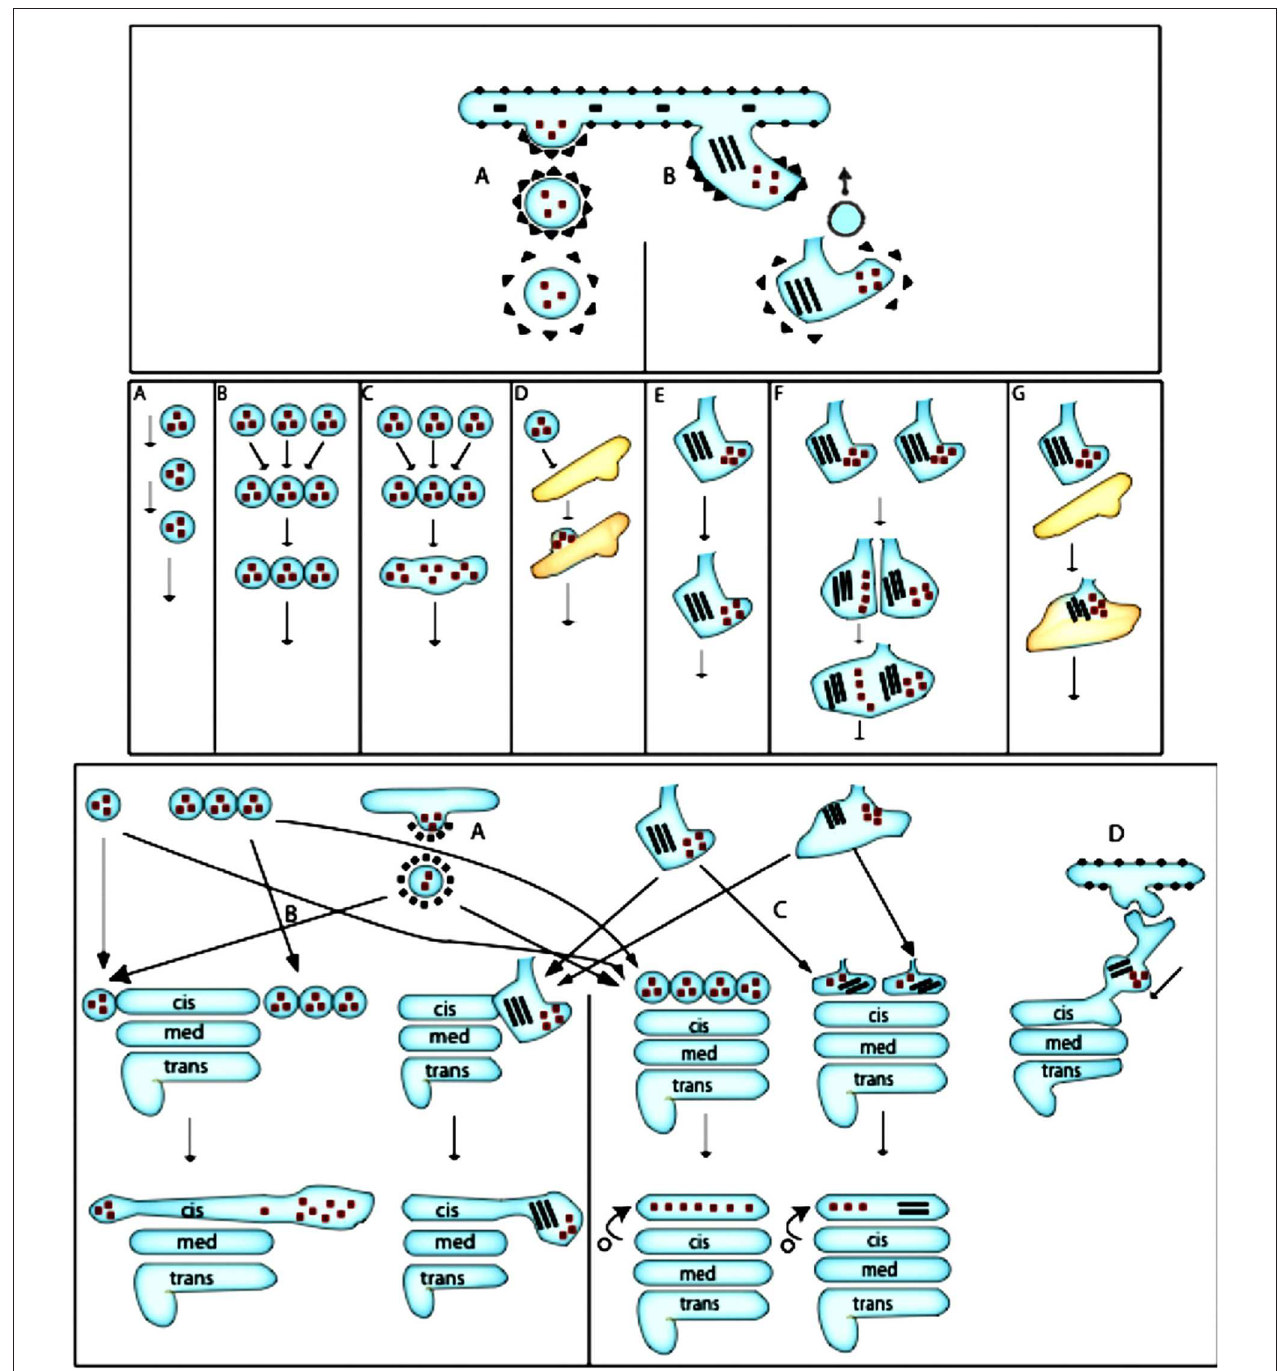
FIGURE 3 | Scheme of ER-to-Golgi transport according to the VM and CMPM. Upper section: (A) Formation of COPII-coated bud. (B) Formation of a COPII-dependent protrusion, which might be partially coated with COPII, for a megacargo inside this protrusion. A COPI vesicle recycles the resident ER proteins. Middle section: (A) Movement of COPII-dependent vesicles one after another toward the Golgi complex. (B) Formation of a vesicle aggregate that moves toward the Golgi complex. Fusion of a COPI vesicle with the formation of a ER-to-Golgi carrier. (D) Delivery and fusion of the COPII vesicle to the intermediate compartment. (E) Movement of the ER protrusion. (F) Fusion of the ER protrusion, with the formation of common carrier. (G) Fusion of the protrusion-dependent ER-to-Golgi carrier with the intermediate ERGIC compartment. Lower section: Different possibilities for the final delivery of ER-to-Golgi carriers to the Golgi complex. Left: According to the pure VM: (A) The additional round of COPII-dependent vesicle formation from the ER-to-Golgi carrier from the intermediate compartment. (B) Delivery of a new vesicle to the Golgi complex. (C) According to the CMPM: COPII vesicles or ER protrusions form the new cis- Golgi cisterna. (D) According to the bolus-like mechanism within the framework of the KARM: Movement of the carrier along the ER-Golgi tubule.